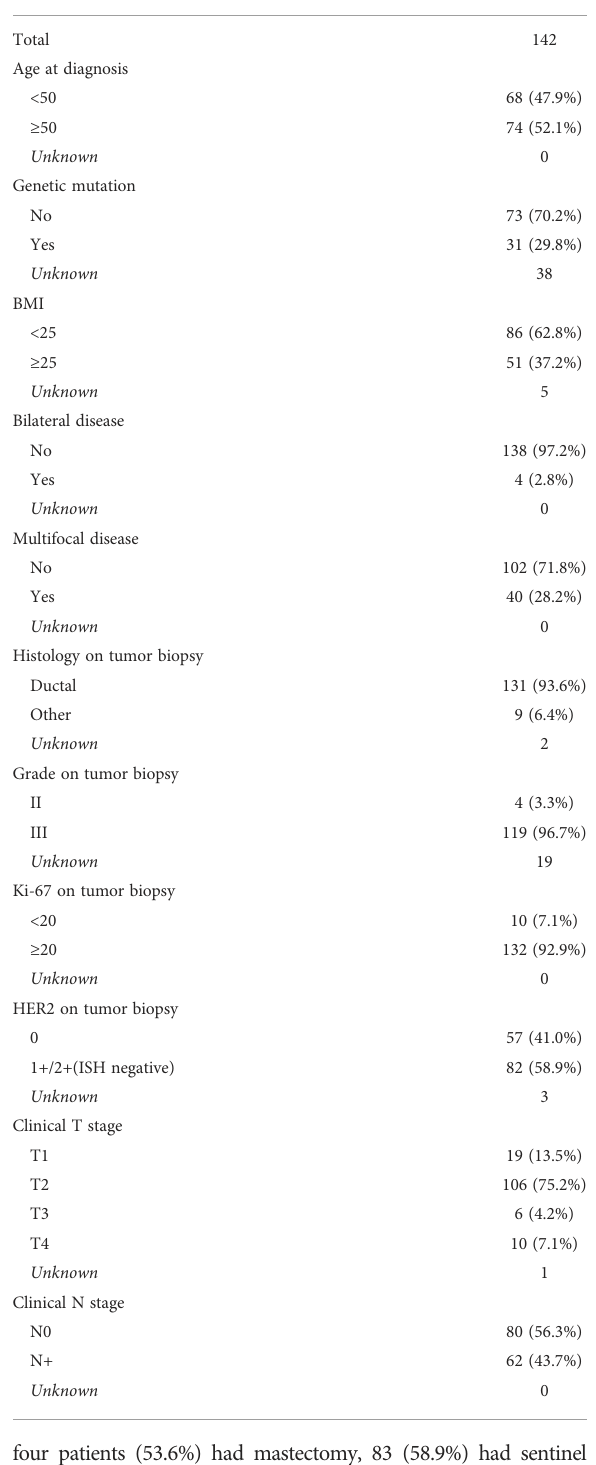
TABLE 1 Characteristics of TNBC patients and histopathological tumor characteristics on tumor